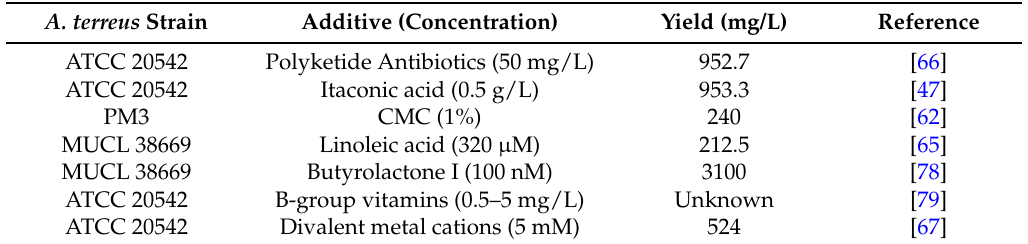
Table 3. Effect of various additives on statin production by various A. terreus